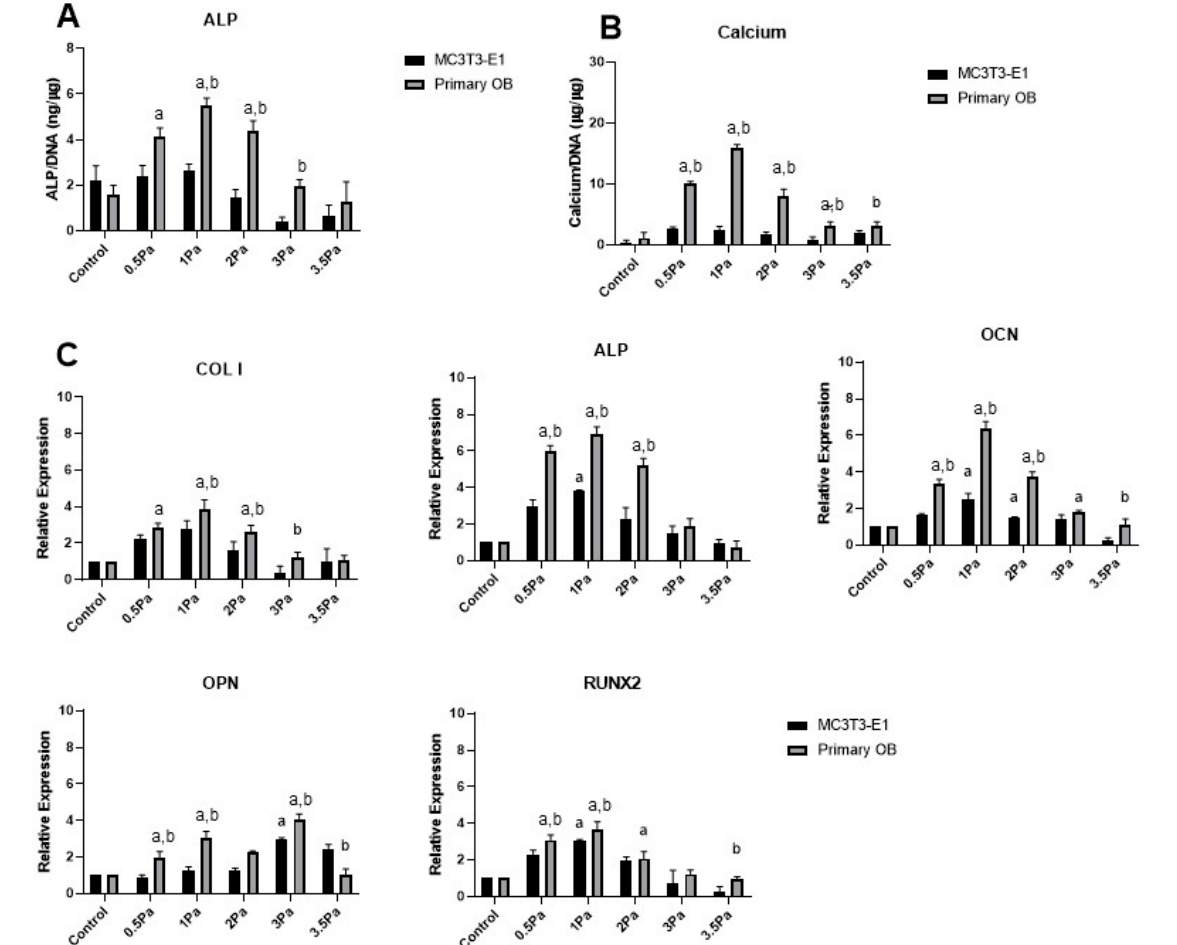
Figure 1. Effect of varying levels of FFSS on MSC-OBs and MC3T3s in terms of ALP, calcium and osteo- genic gene expression. ( A ) ALP levels in both cell types at pre-determined FFSS levels, normalized to DNA content. ( B ) Calcium levels in both cell types at pre-determined FFSS levels, normalized to DNA content. ( C ) Gene expression levels for Collagen I, ALP, OCN, OPN and RUNX2 mRNA in MSC-OB cells via RT-PCR. Expression data were calculated using the 2 −ΔΔ Ct method relative to baseline levels and nor- malized using 18S as endogenous control. All regimes shown were carried out at a frequency of 1 Hz for a duration of 1 h. Statistical differences are shown where (a) represents significant difference compared with respective control/no-flow conditions, at a level of p < 0.05 and (b) represents significant difference compared with cell-line counterpart under identical FFSS conditions, at the level of p < 0.05.